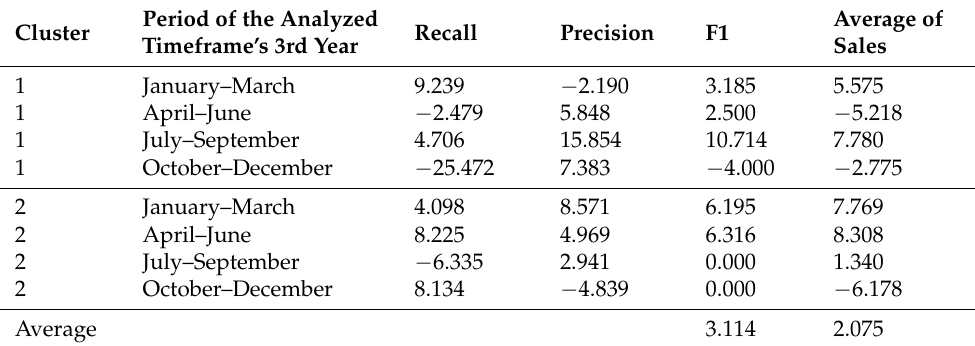
Table 10. The percentage difference between the proposed RS and the current RS.